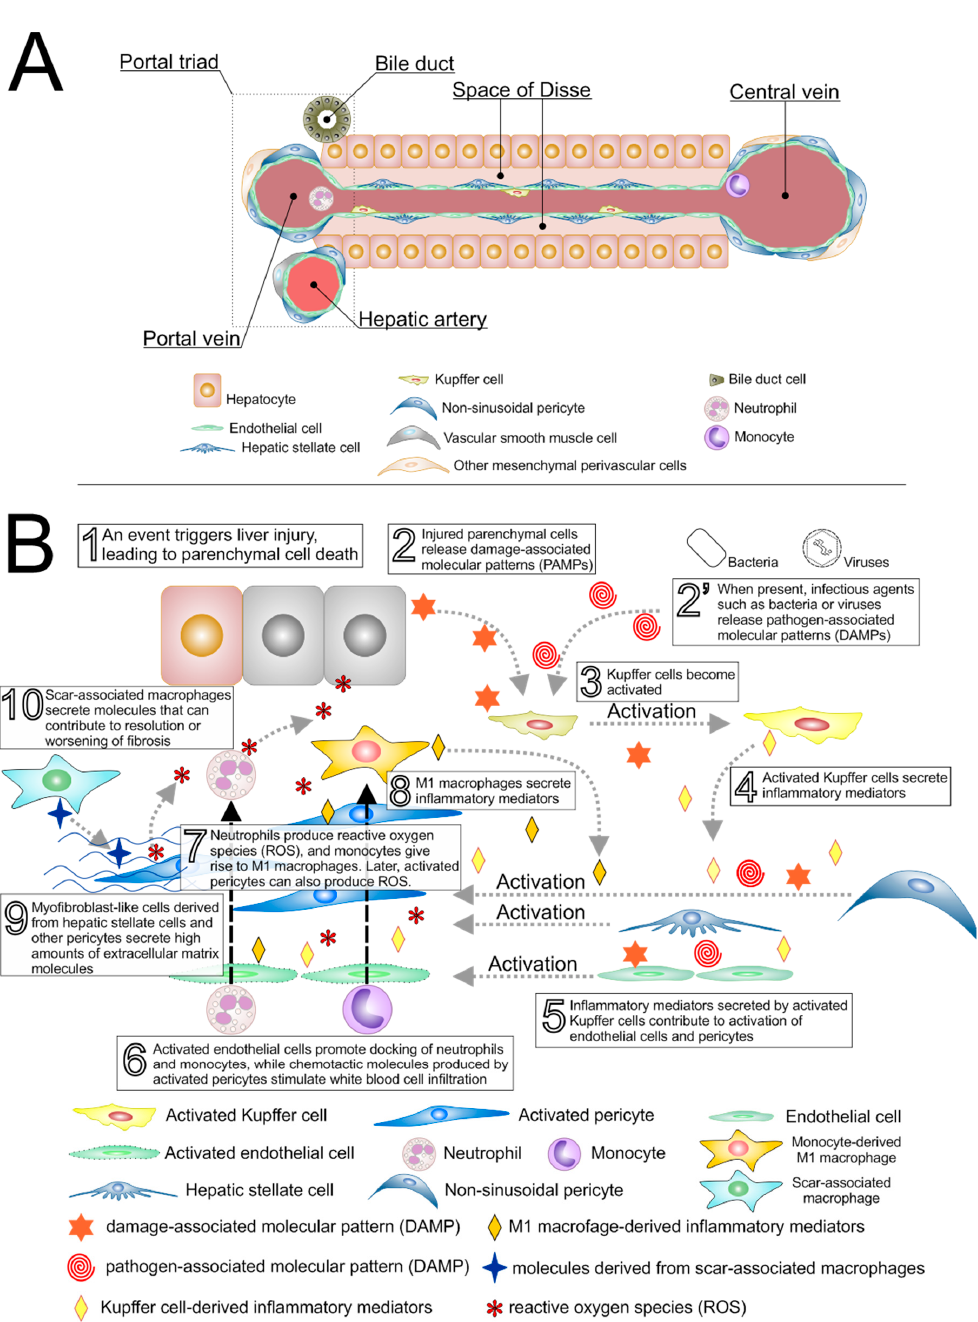
Figure 1. Interactions between inflammatory cells, perivascular cells, and endothelial cells at the onset and after a liver injury event. ( A ) Depiction of cells and structures in the liver under normal circumstances; ( B ) Sequence of events involved in the progression of various types of liver